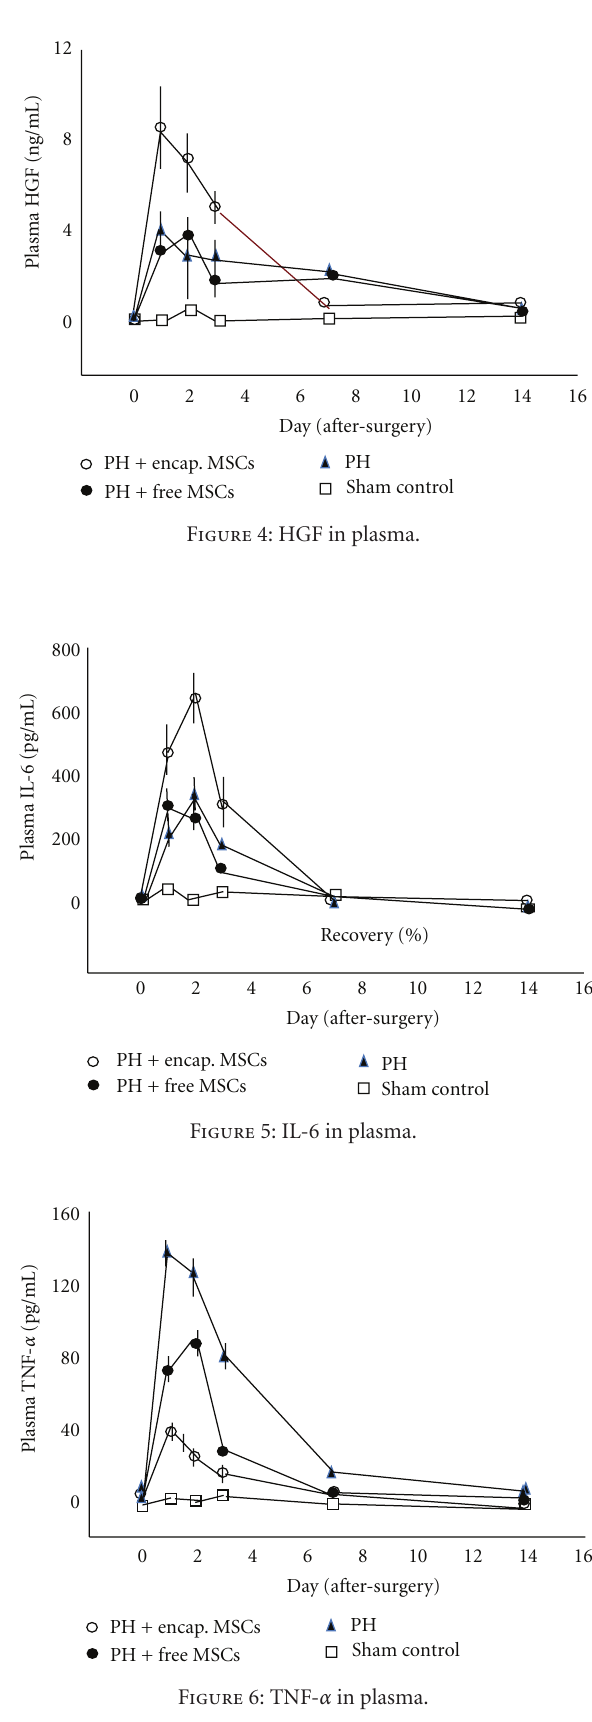
Figure 6: TNF- α in